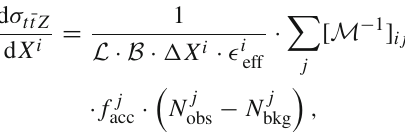
Table 8 Summary of the variables used for the differential measure- ments. Some variables are considered for the trilepton or tetralepton signal regions only, as indicated. The jet multiplicity is measured for